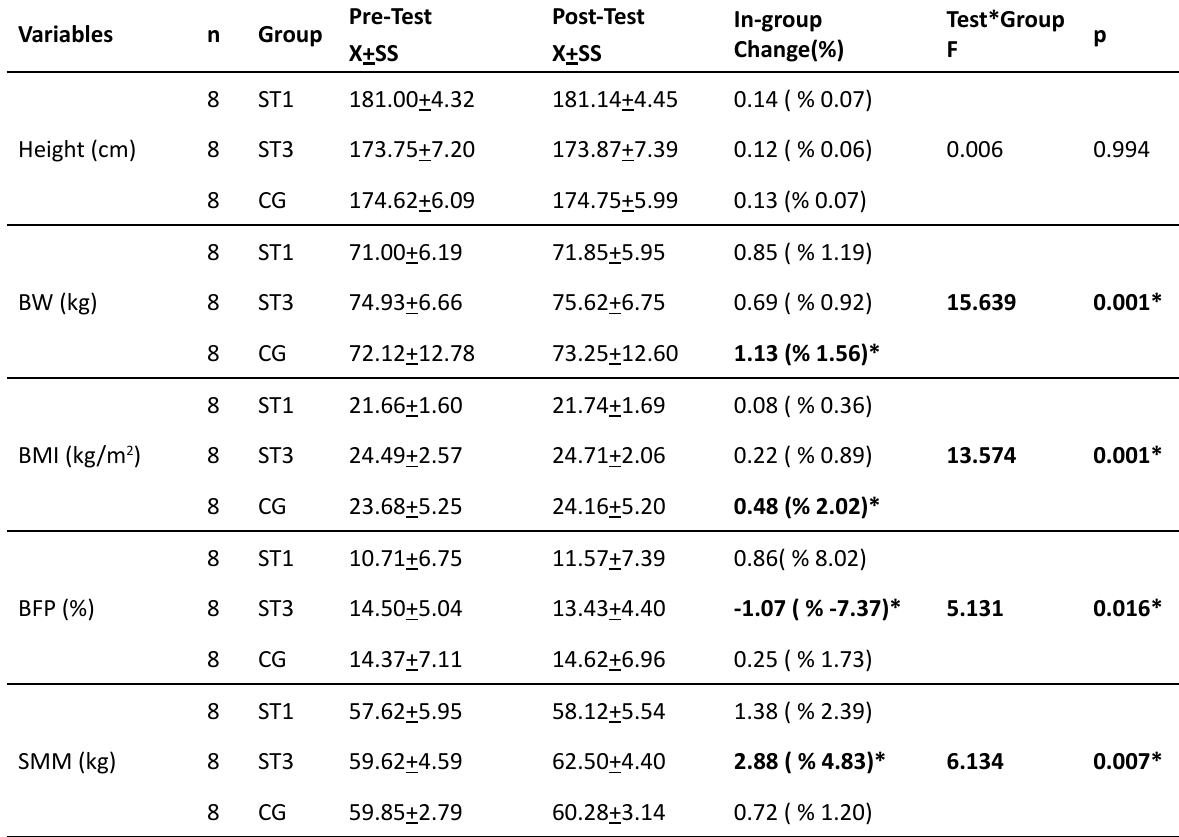
Table 2. Comparison of physical features among groups